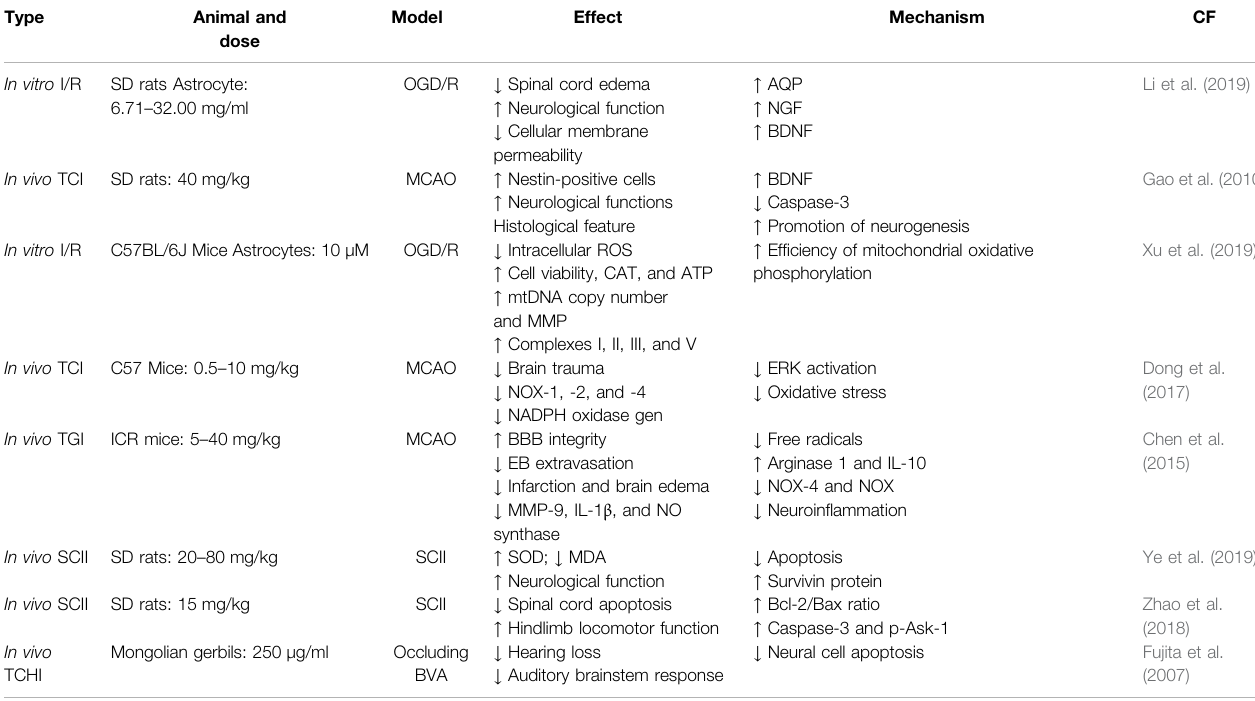
TABLE 3 | Antioxidant effects of GRb1 on I/R neuronal injury mediated by the inhibition of oxidative stress and mitochondrial injury, increases in energy metabolism and protection of the BBB, based on recent reports and results.